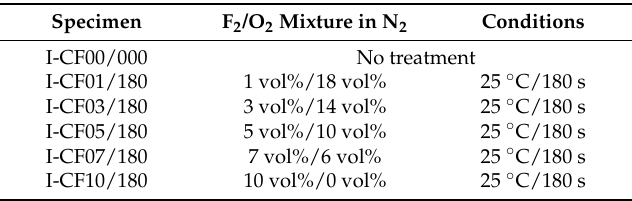
Table 1. Reactive conditions for oxy-fluorination treatment.